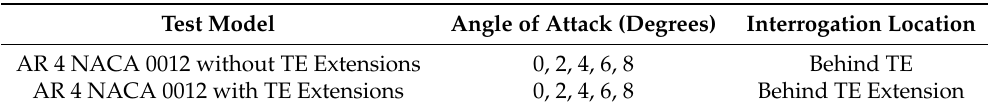
Table 3. Test Matrix for Free Shear Layer (FSL) Particle Image Velocimetry (PIV) interrogation.